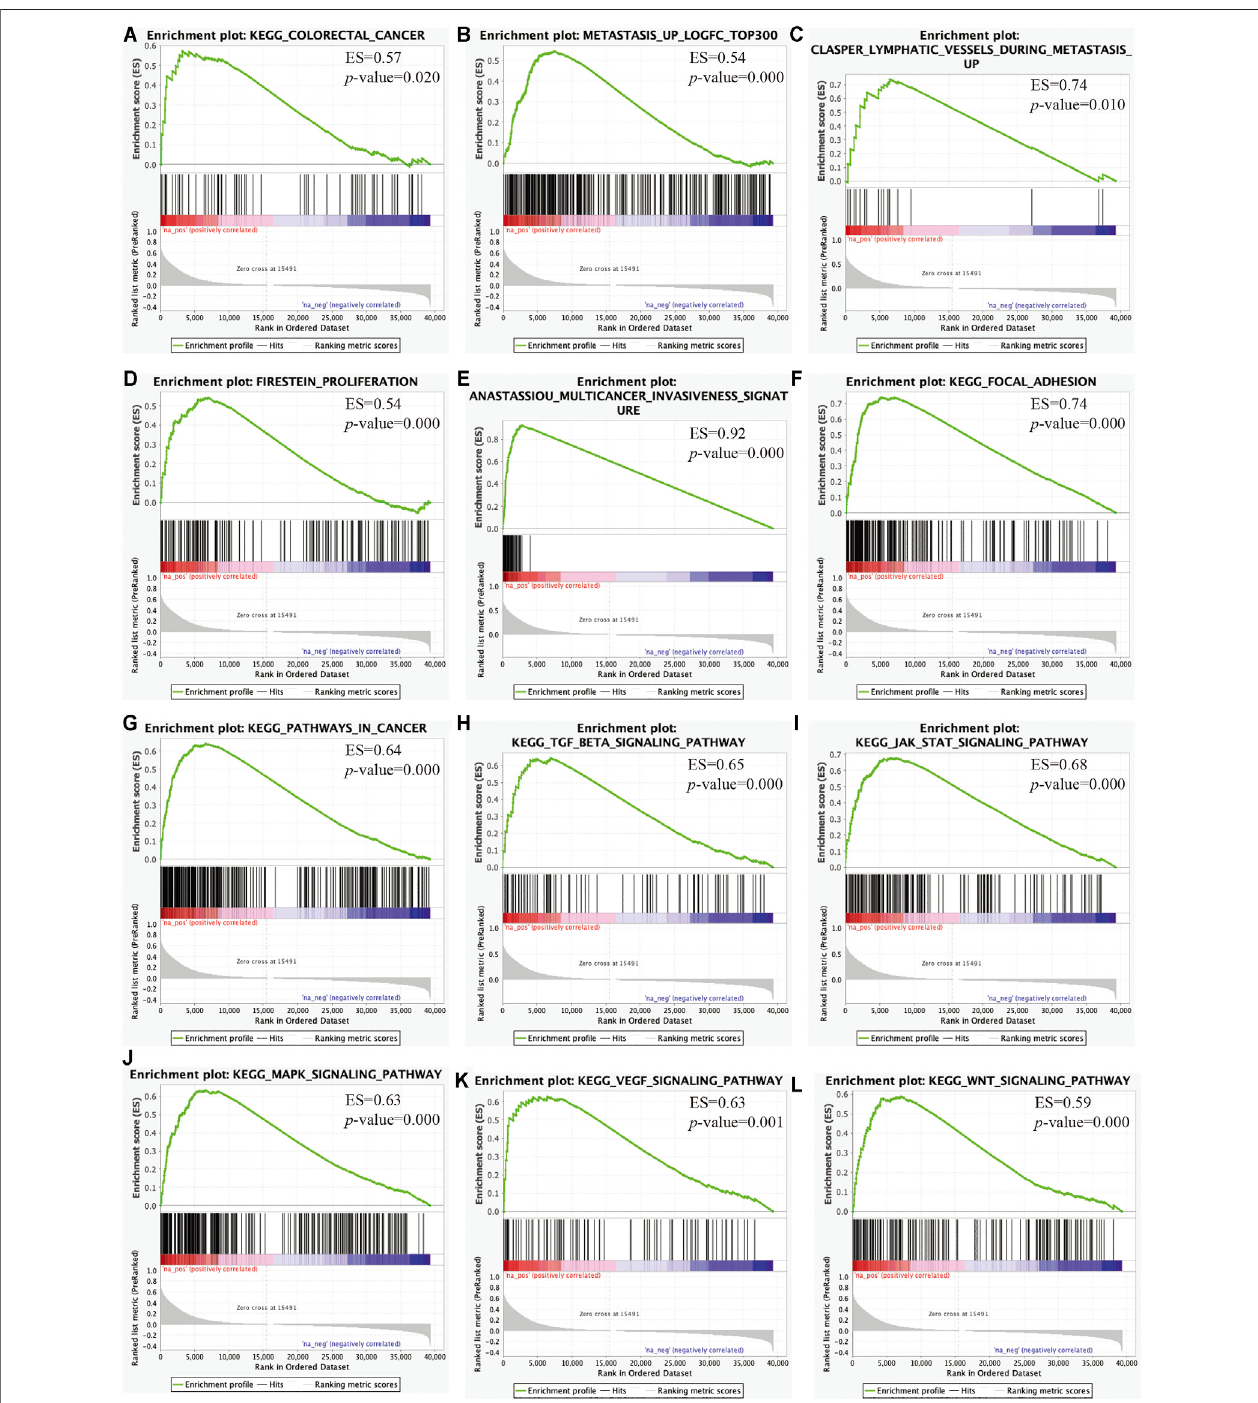
FIGURE 7 | Identi fi cation of key pathways and gene sets associated with colorectal cancer prognosis based on TCGA-COAD RNA-Seq dataset via gene set enrichment analysis (GSEA). Gene sets for colorectal cancer (A) , lymphatic metastasis (B) , lymphatic vessels during metastasis (C) , proliferation (D) , multicancer invasiveness signature (E) , focal adhesion (F) , pathways in cancer (G) , TGF-BETA signaling (H), JAK-STAT signaling (I) , MAPK signaling (J), VEGF signaling (K) , and WNT signaling (L) were signi fi cantly enriched. Samples were categorized according to the median expression level of C3 gene. A raw p -value less than 0.05 indicated statistical signi fi